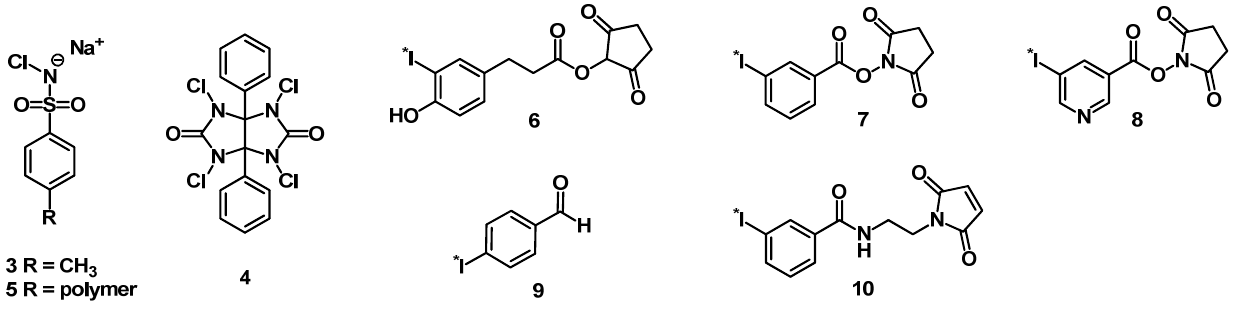
Figure 3. Chemical structure of N -chloroamide oxidizing agents and prosthetic groups for radioiodination of